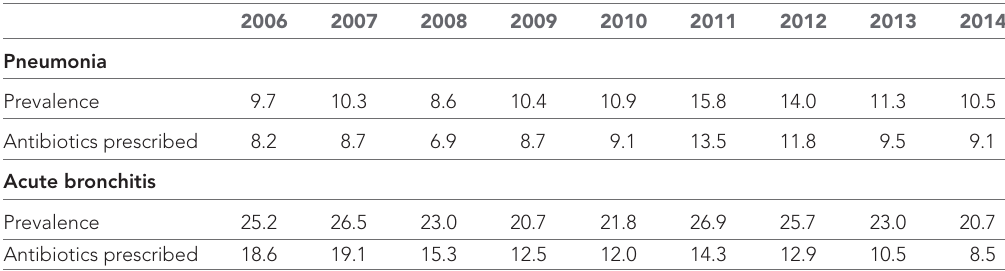
Table 2 Prevalence of pneumonia and acute bronchitis, and antibiotics prescribed in patients aged 18–79 years in primary care ( n /1000 inhabitants each